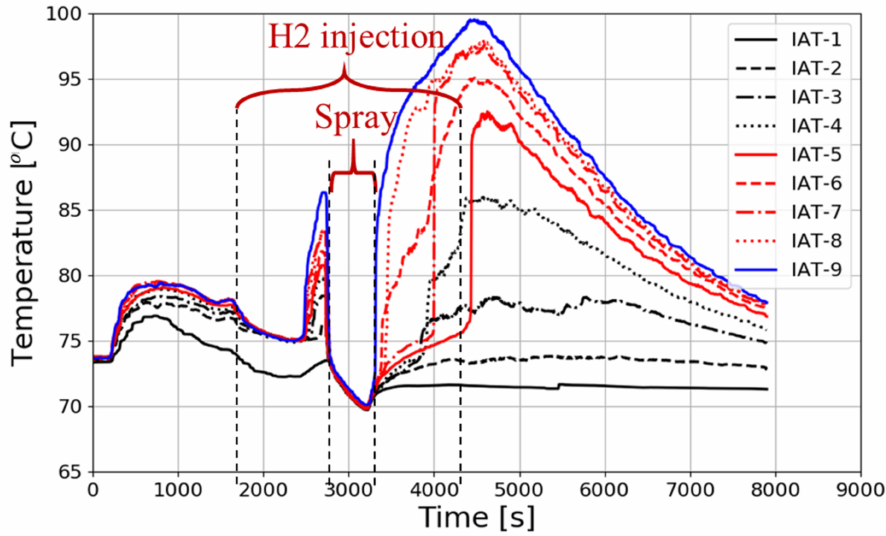
Figure 21. Time variations of the gas temperatures measured during the SSP4